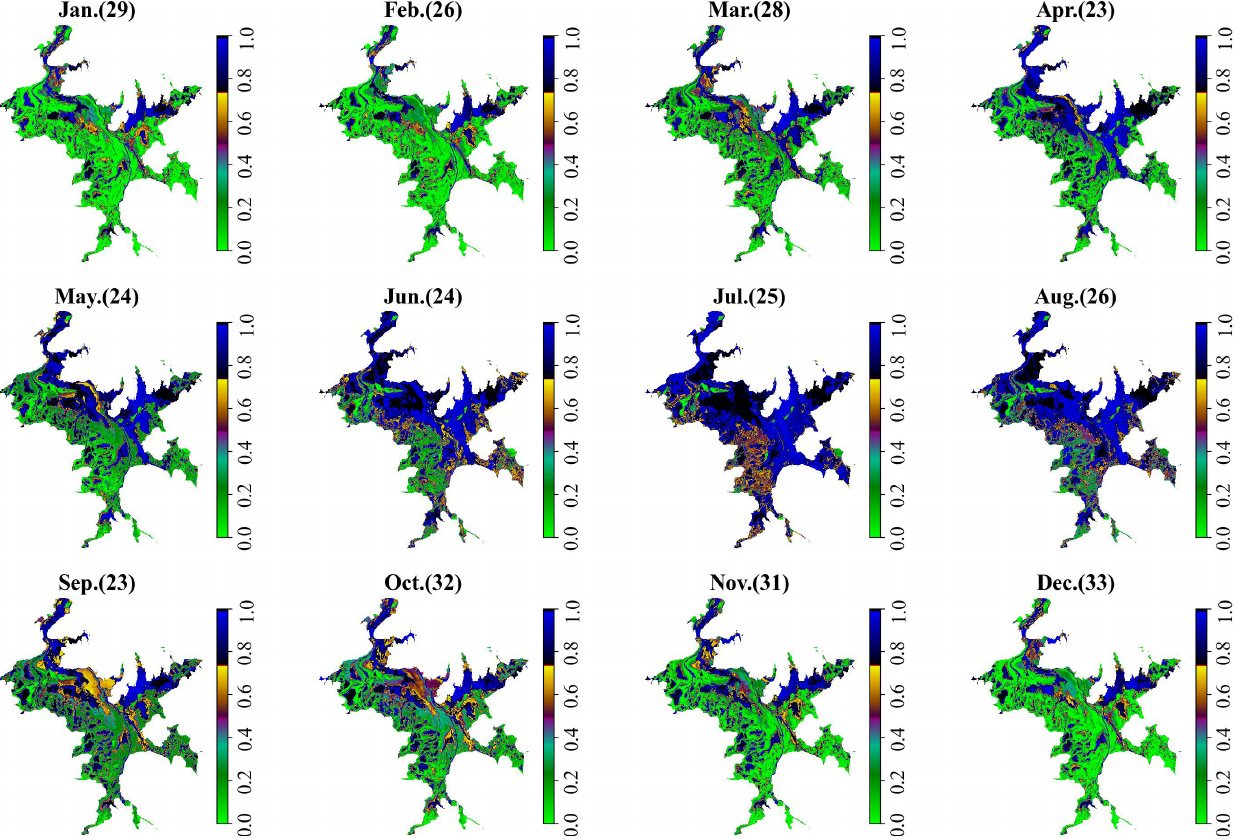
Figure 14. The IF distribution maps for different months from 2014 to 2021. The numbers in the brackets are the observation times for that month across all